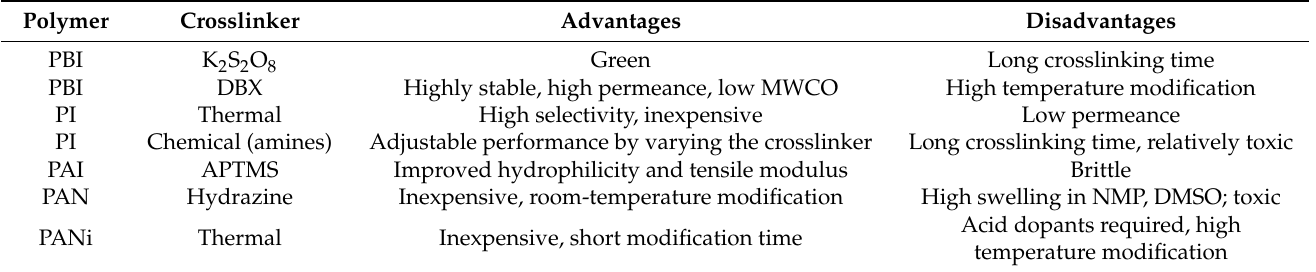
Table 3. Advantages and disadvantages of various crosslinking methods. Reprinted and adapted with permission from Ref. [49]. Copyright 2019, ACS